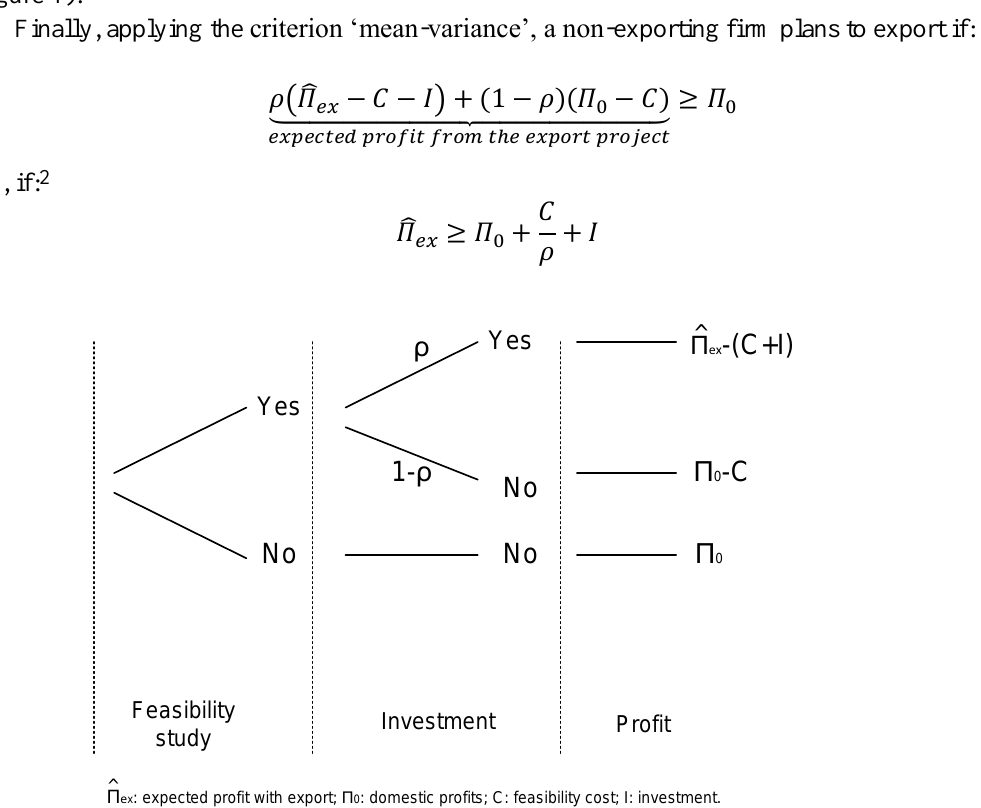
Figure 1 : The decision tree concerning an export